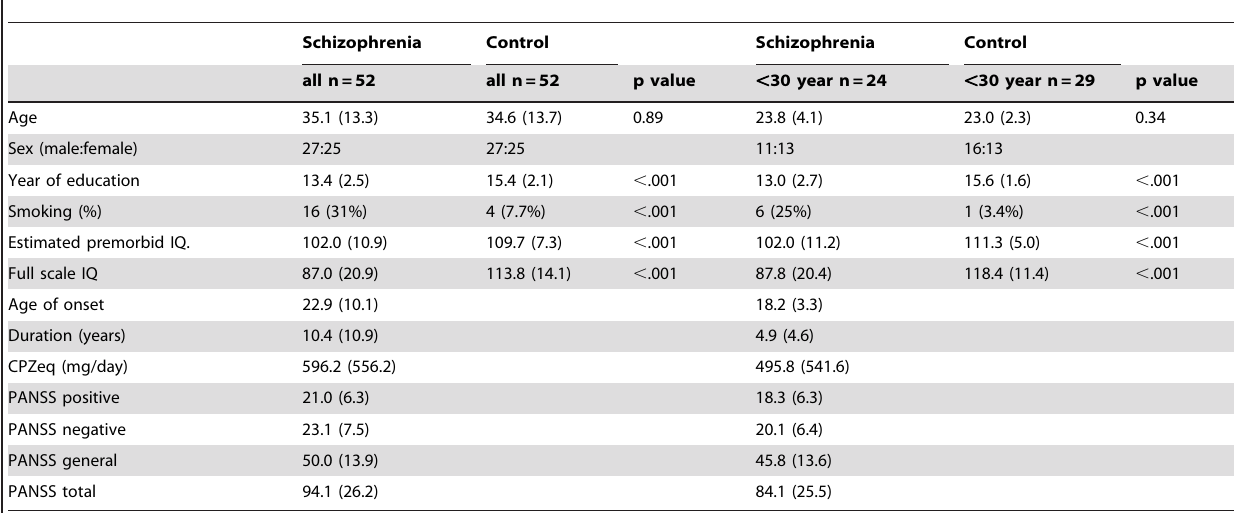
Table 1. Clinical characteristics of patients with schizophrenia and healthy controls.